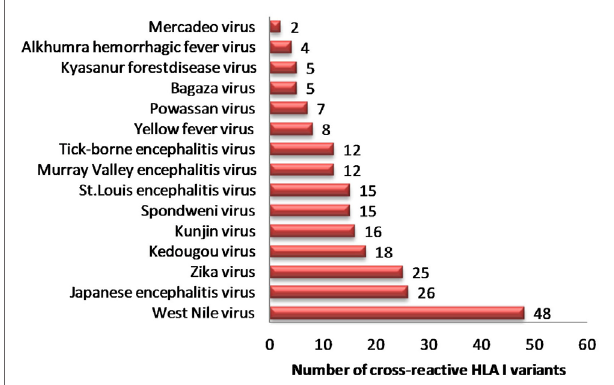
FigUre 1 | Distribution of dengue hemorrhagic fever-associated HLA-I binders from dengue virus cross-reactive to related